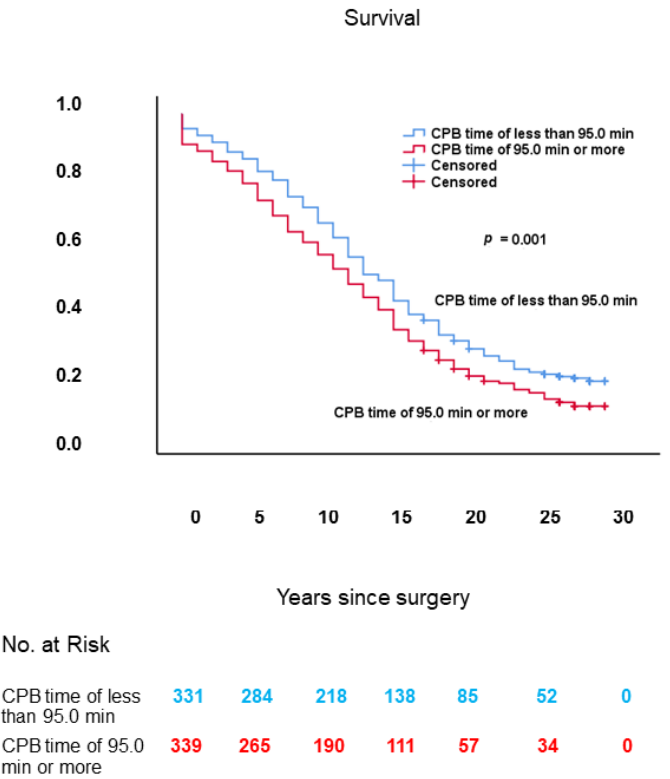
Figure 9. Kaplan–Meier survival curves, from date of surgery, of patients with CPB time of 95.0 min or more vs. those with CPB time of less than 95.0 min. CPB: cardiopulmonary bypass.